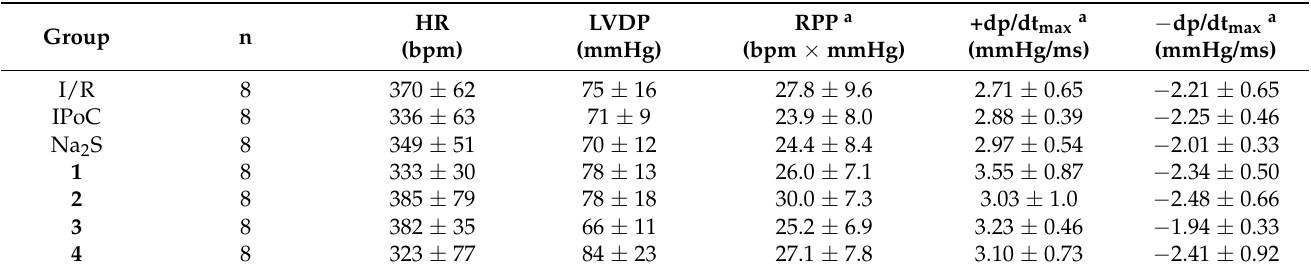
Table 1 . Isolated heart parameters taken at the end of the stabilization time in the different treatment groups.